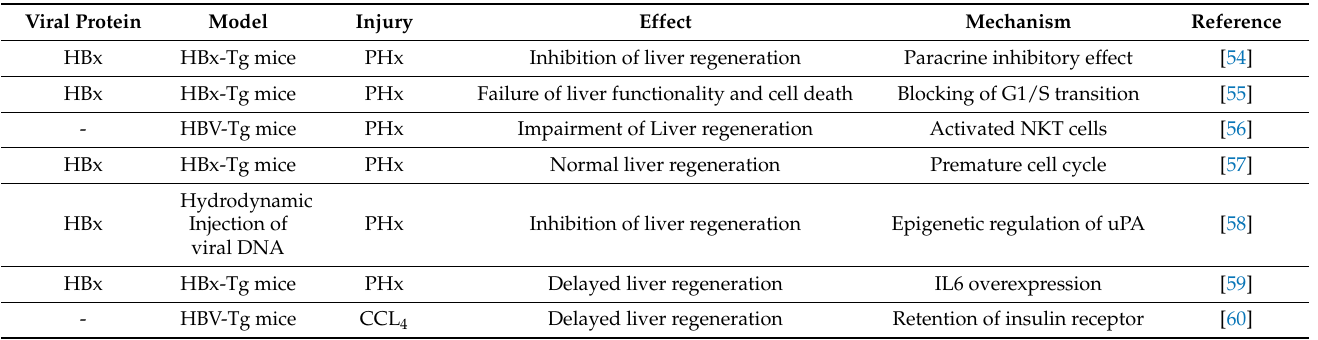
Table 1. Studies on the effect of hepatitis B virus infection on liver regeneration using mouse models. Viral